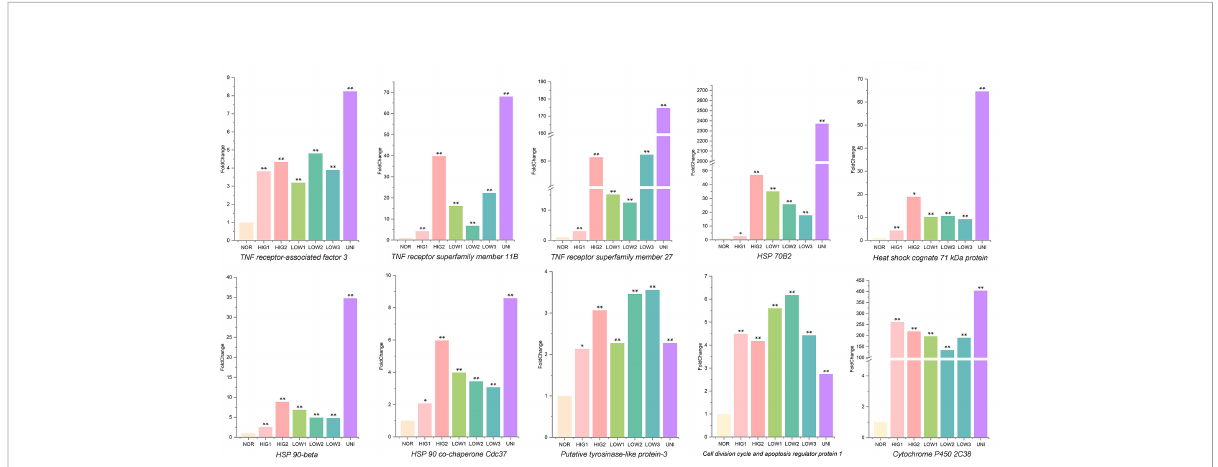
FIGURE 6 Levels of mRNA expression associated with key candidate genes involved in stress response in the Yesso scallop. (Values marked with an asterisk indicate signi fi cant differences, *p-value < 0.05, **p-value < 0.01; HIG1and HIG2, heat stress at 22 and 25°C; LOW1-LOW3, hypoxia stress at DO levels of 6 mg/L, 4 mg/L, and 2 mg/L; UNI, stress due to heat and hypoxia at 25°C and 2 mg/L DO; NOR, normal conditions at 15°C and 8 mg/L